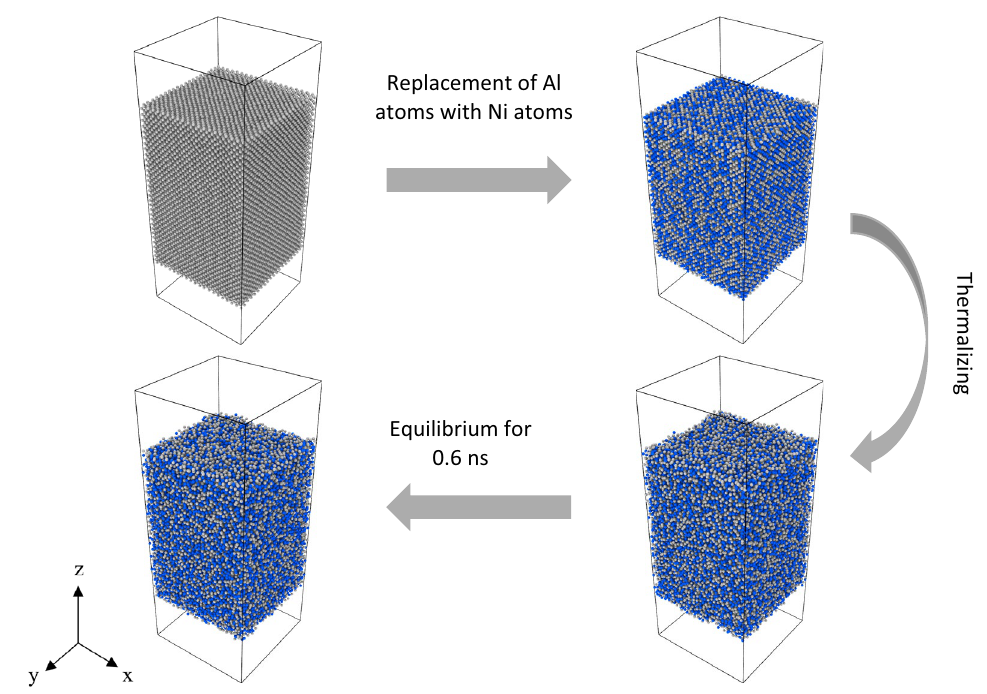
Figure 1. Al–0.5Ni system preparation. Aluminum and Nickel atoms are colored gray and blue